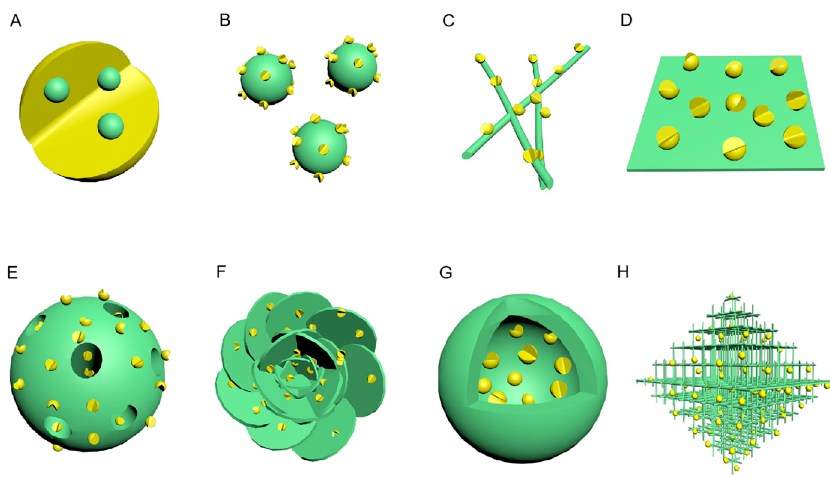
Figure 2. Representative morphologies of nanobiocatalysts with increased activities. ( A ) Insertion of nanoparticles into enzyme molecules. ( B–D ) Immobilization of enzymes on the surface